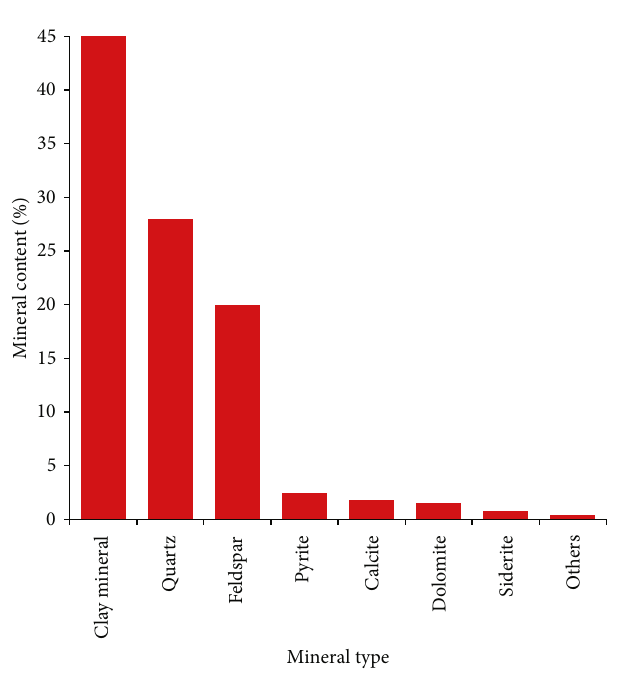
Figure 1: Mineral content of source rocks.